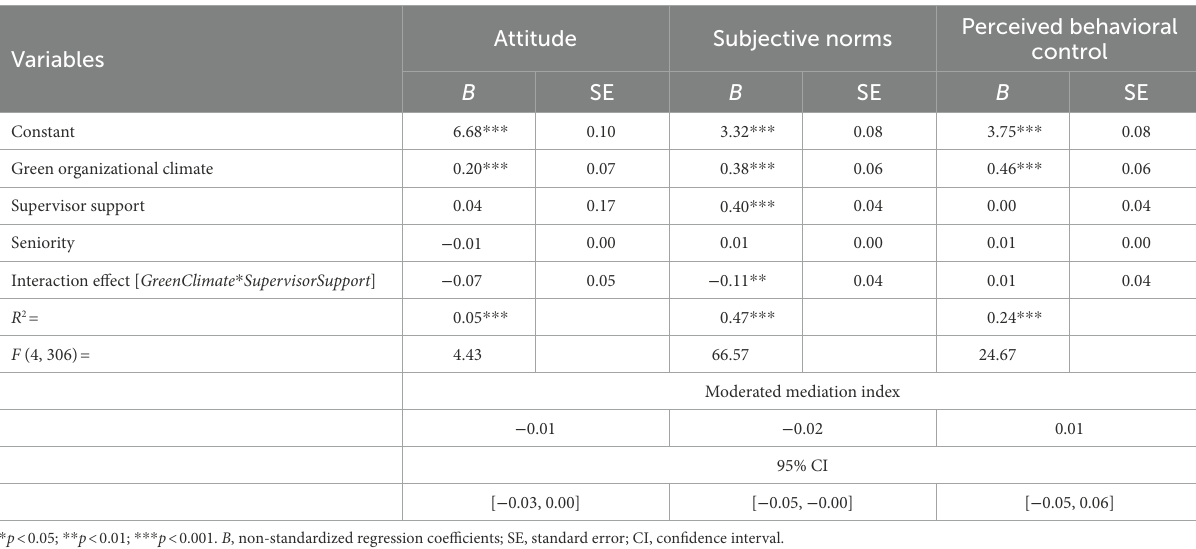
TABLE 4 Moderation and mediated moderation for paper separation.